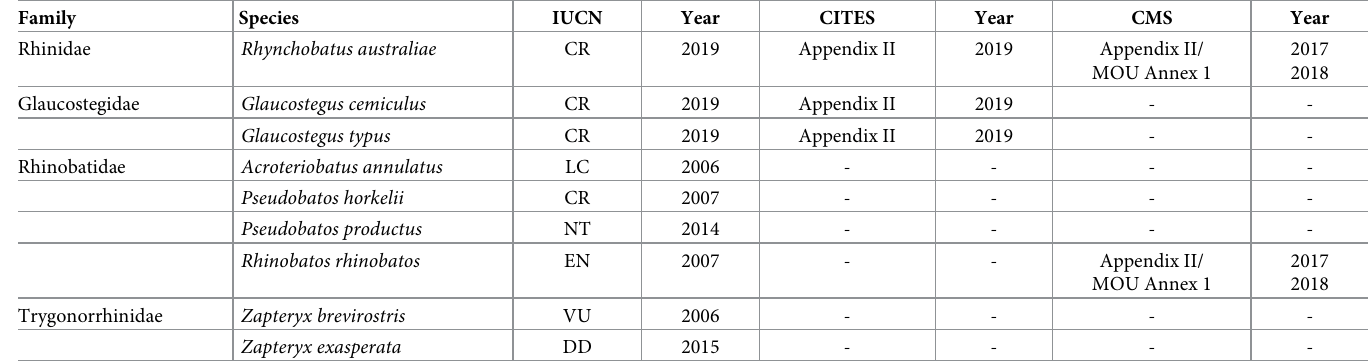
Table 1. The nine species of shovelnose rays in this study. Listed is their threat status according the International Union of Conservation of Nature’s (IUCN) Red List of Threatened Species, and whether the species are listed on the appendixes of CITES, and/or CMS, and the CMS Sharks MOU (MOU). IUCN categories are CR, Critically Endangered; EN, Endangered; VU, Vulnerable; LC, Least Concern; DD, Data